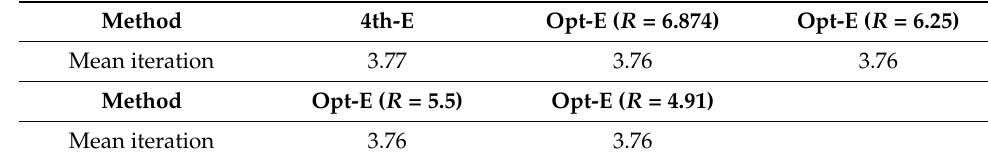
Table 4. Mean numbers of iterations for explicit